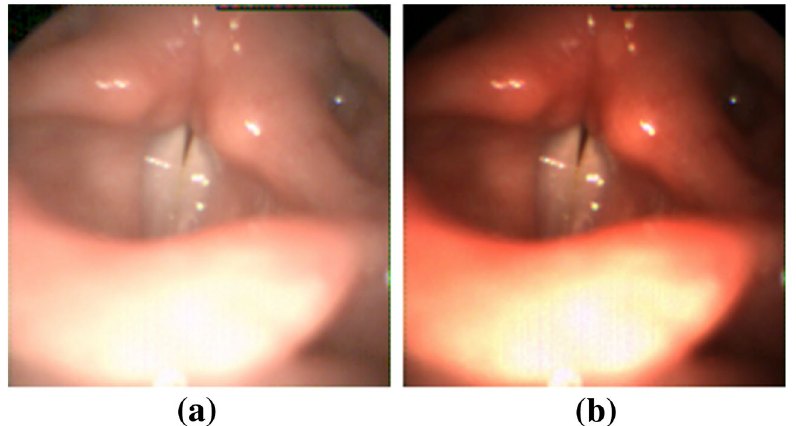
Figure 1. Images from a high-speed video (HSV) recording of one subject with insufficient closure of the rear region of the glottis with and without gamma correction: ( a ) original image; ( b ) gamma-adjusted image with photo-editing software (ImageJ) was used for image